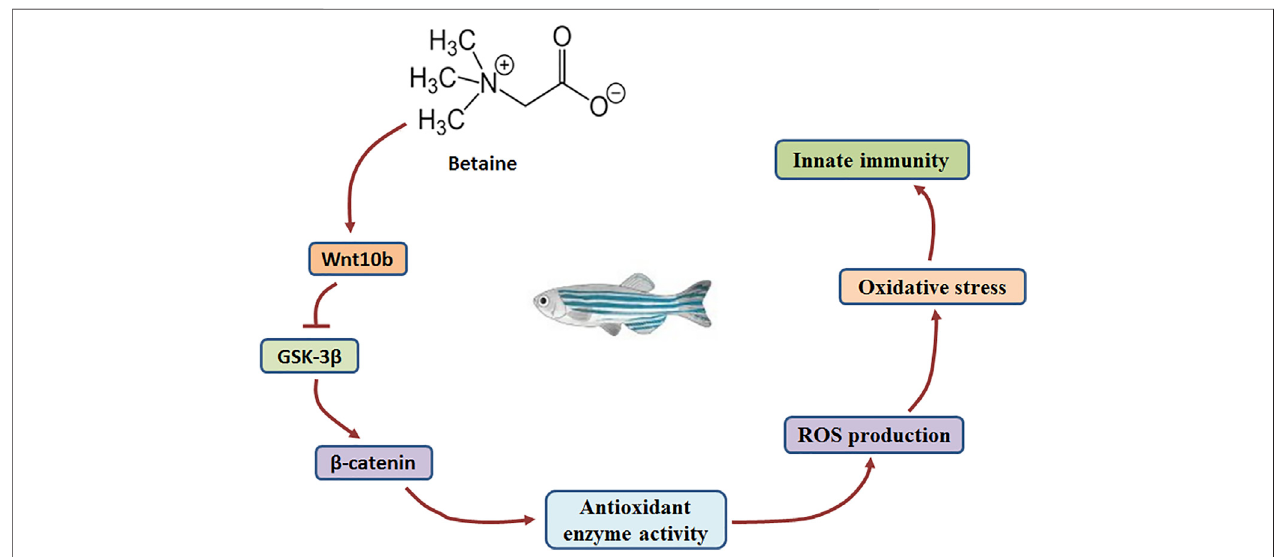
FIGURE 5 | The mechanism by which betaine regulates the production of ROS through Wnt10b/ β -catenin signaling pathway in the zebra fi sh liver.